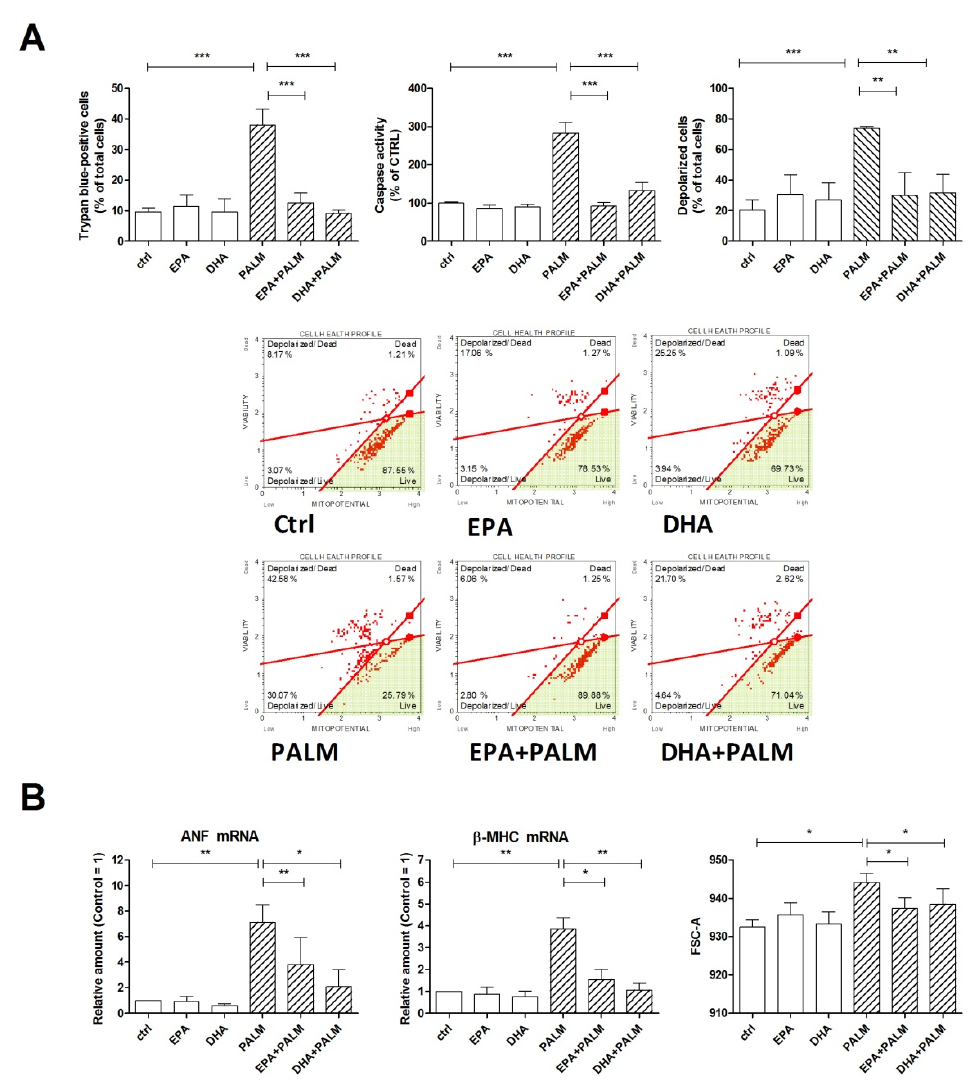
Figure 1. Effect of n-3 polyunsaturated fatty acids (PUFAs) on hypertrophy, mitochondrial potential, and survival of H9c2 cardiac cells exposed to palmitate. H9c2 cells were incubated under control condition (ctrl), in the presence of 500 µ M palmitate (PALM), 60 µ M eicosapentaenoic acid (EPA), 60 µ M docosahexaenoic acid (DHA), or a combination of fatty acids, as indicated, (EPA + PALM; DHA + PALM). ( A ) Cell viability was assessed after 24 h treatment by trypan blue exclusion test to calculate the percentage of dead cells or analyzed for caspase activity. Alternatively, H9c2 cells were treated for 16 h, then analyzed for mitochondrial membrane potential to calculate the percentage of depolarized cells. Panel A, bottom: representative dot plot data output of mitochondrial depolarization are reported. ( B ) After a 16 h incubation, H9c2 cells were analyzed by RT-PCR for the relative amount of ANF mRNA and β -MHC mRNA, as markers of cardiac hypertrophy; in addition, cell size was analyzed in a flow cytometer by measuring the forward scattering (FSC). Differences are indicated with ns (not significant) for a p -value > 0.05, or with *, **, ***, for p < 0.05, p < 0.01, and p < 0.001, respectively.